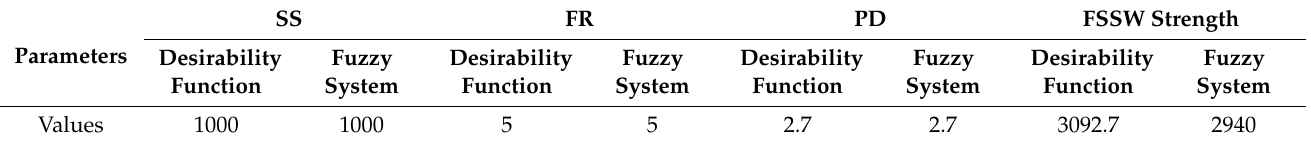
Table 10. The optimum values of static welding parameters of desirability function and fuzzy